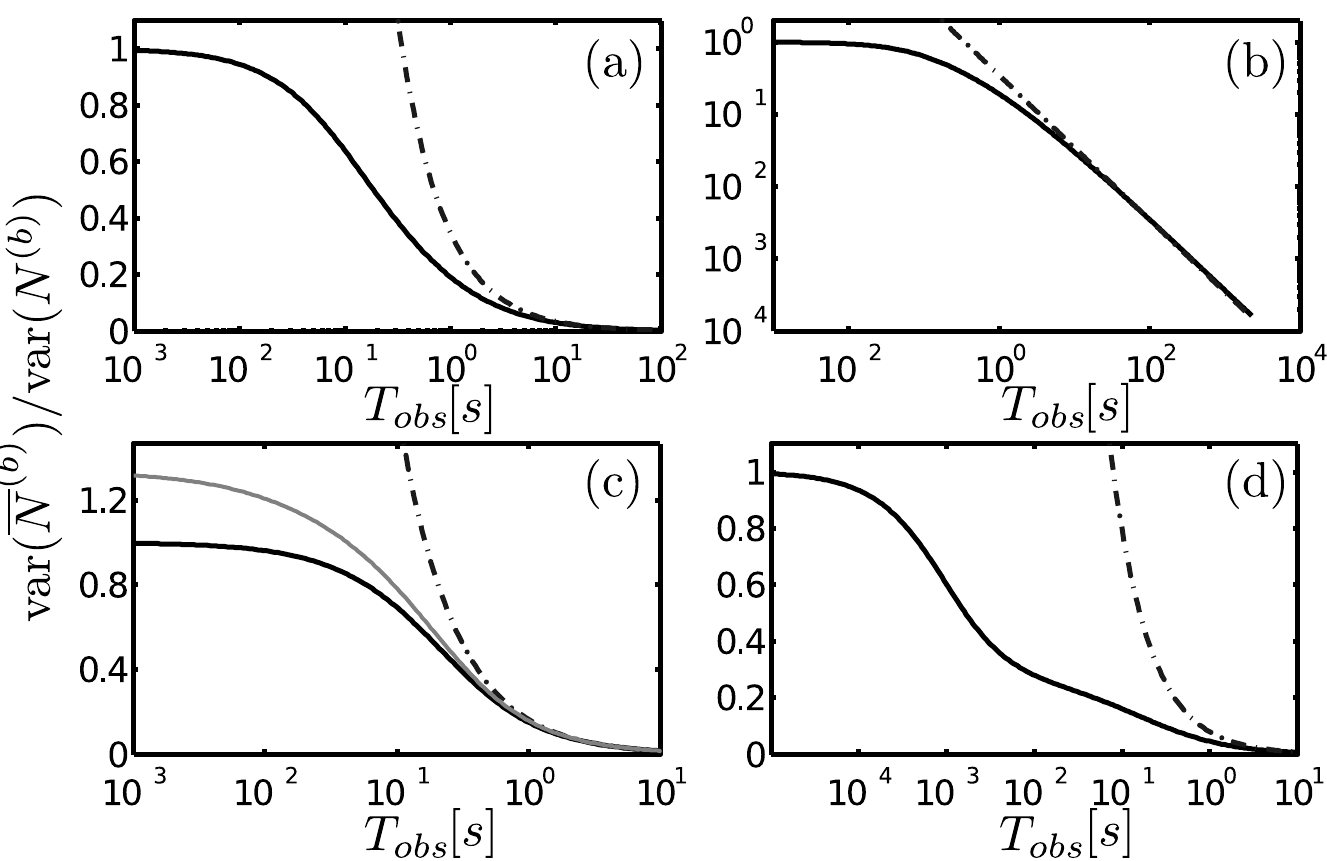
Fig 1. Relative error of the average number of bound particles as a function of time. Eq (7) with τ ( b ) given by Eq (12) (dashed-dotted curve) is plotted in all subfigures. (a) The fr limit holds. Eq (24) (black solid curve) and Eq (25) (dashed-dotted curve) are also plotted. (b) Same as (a) but with the vertical axis on a logarithmic scale. (c) The fd limit holds. Eq (22) (black solid curve) and the combination of Eq (3) and Eq (27) (gray solid curve) are also plotted. (d) Similar to (a) but for parameters such that D r ð N ð b Þ Þ goes below 10% for T obs much smaller than the longest correlation time which is * 1 s